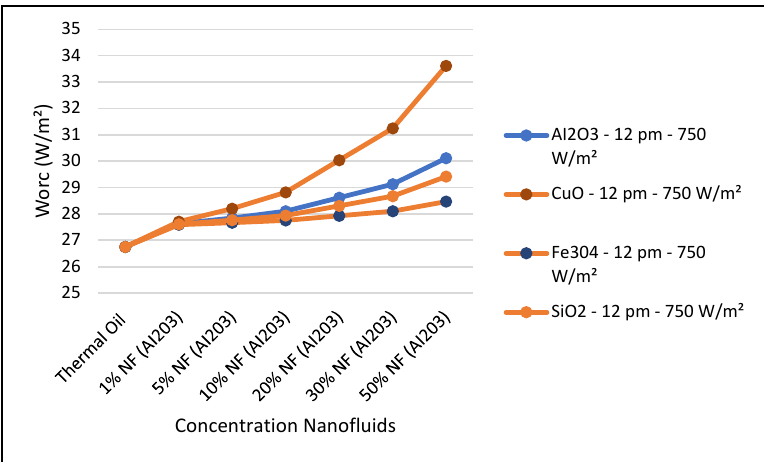
Figure 26. CSP system hybrid ORC work produced with different nanofluids at different concentrations.